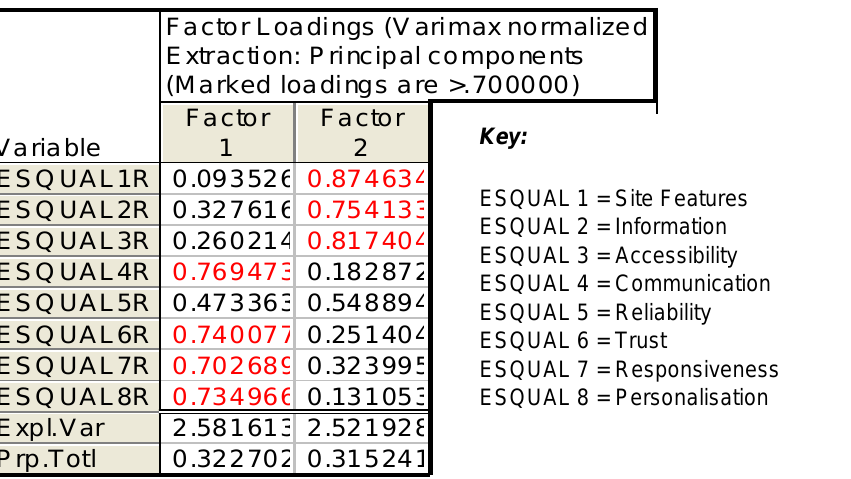
Table 4: Factor loadings extracted from the Exploratory Factor Analysis